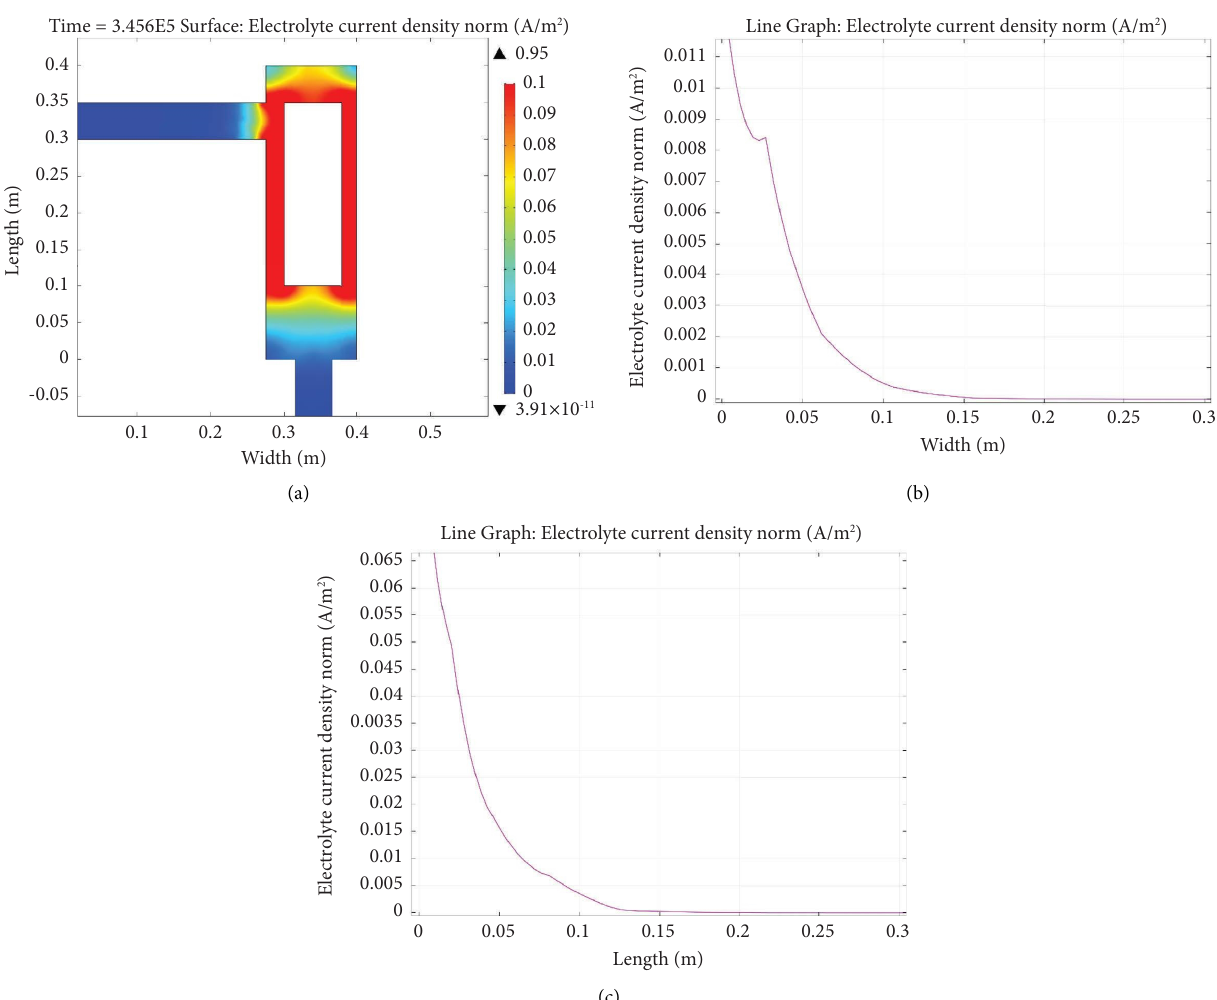
Figure 2: Imposed cathodic current distribution in the electrolyte: (a) around the magnesium anode; (b) along the upper pipeline; (c) along the lower